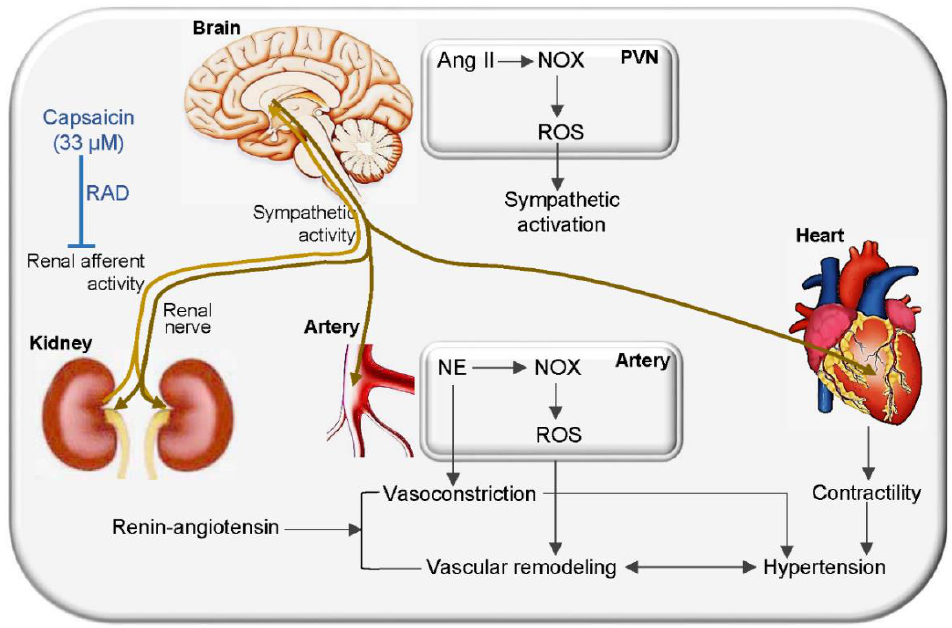
Figure 10. Schematic diagram showing the effects and mechanisms of renal afferent denervation (RAD) on vascular remodeling and hypertension in SHR.